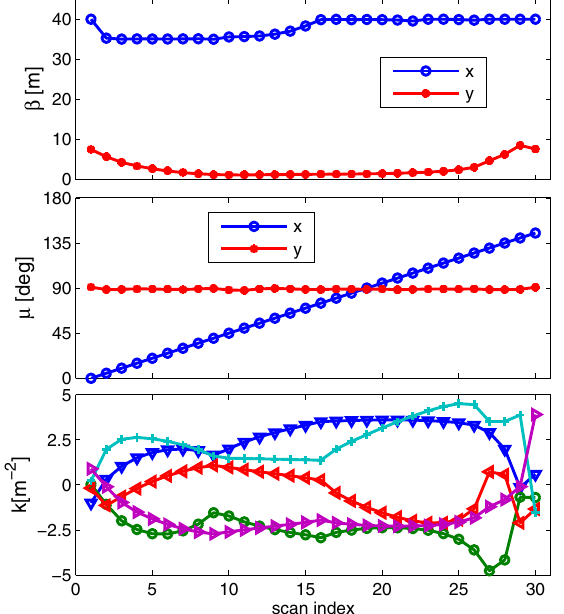
FIG. 4. Optics for the slice emittance measurements. The β -functions at the measurement screen (top), phase advance between deflector and screen (middle), and the required k -values for the measurement quadrupoles during the scan (bottom), plotted for each scan index i .